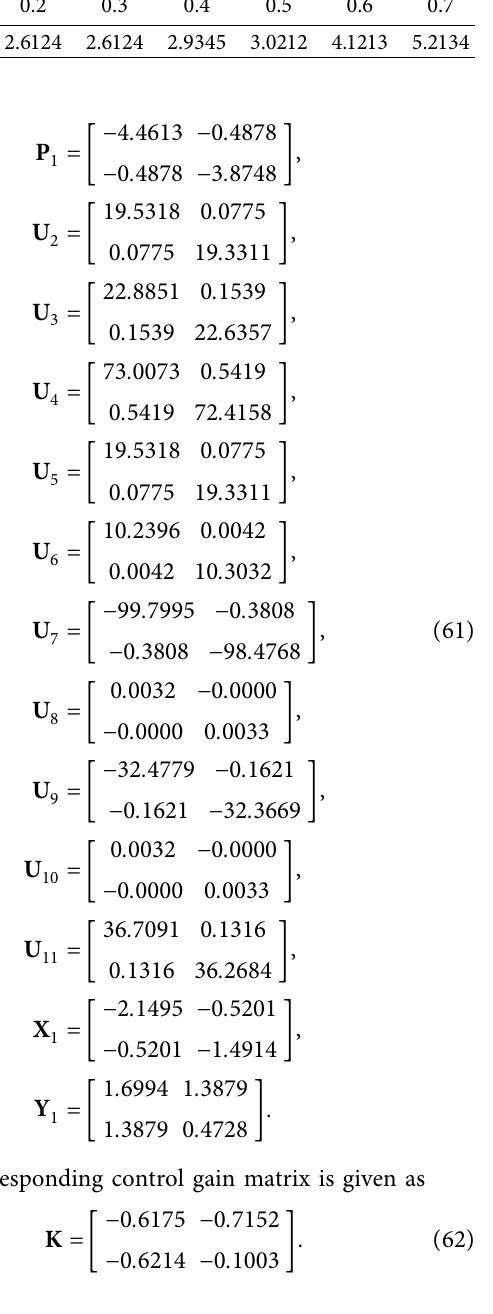
with different values of 2